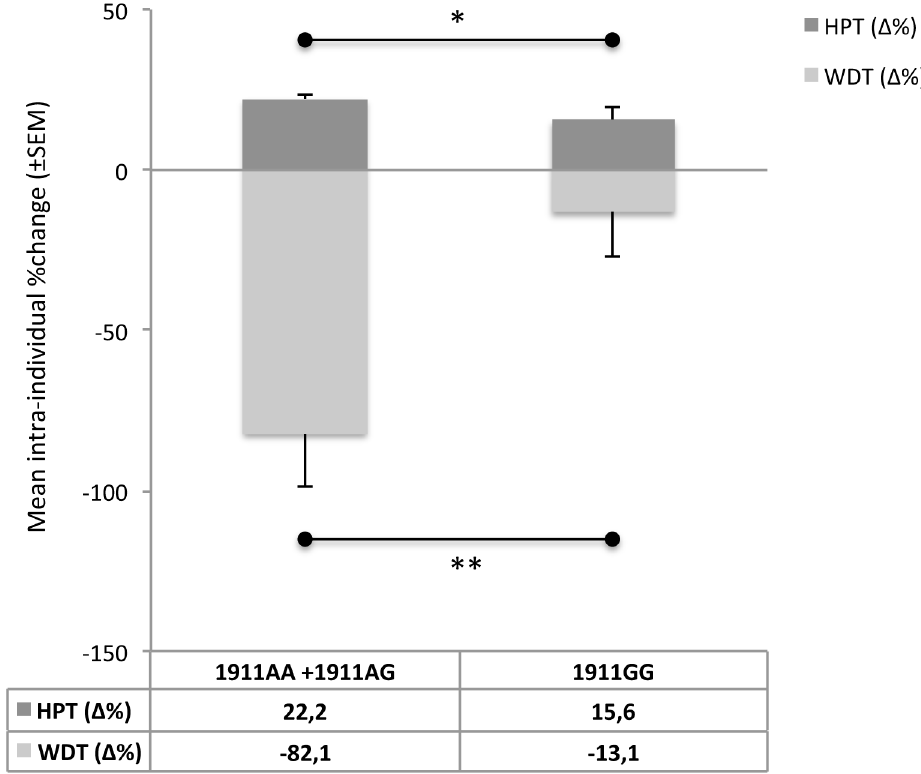
Fig 2. Thermal quantitative sensory testing of TRPV1 variants. Comparison of intra-individual data ( Δ % changeprior vs. after capsaicin) of homozygous G (1911GG) againsthomozygous and heterozygous A carriers (1911AA+1911AG) reveals lower changes (1) towards loss of warm detectionin GG (13.1%) comparedto AA/AG (82.1%) and (2) towards gain of heat pain sensitivity in GG (15.6%) comparedto AA/AG (22.2%) ((1) p = 0.009; (2) p = 0.021). Note: Data are displayedas means ( ± SEM) for all analyzedpatients. P < 0.05considered significance. ((1)Mann-Whitney U test, (2)ANCOVA). * p < 0.05; ** p <